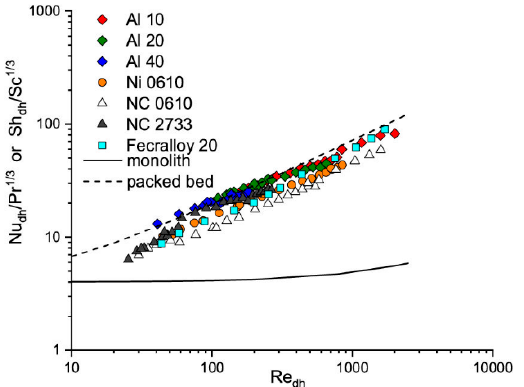
Figure 1. Heat and mass transfer experimental results vs. Reynolds number for tested solid foams. The monoliths and packed bed are shown for comparison.